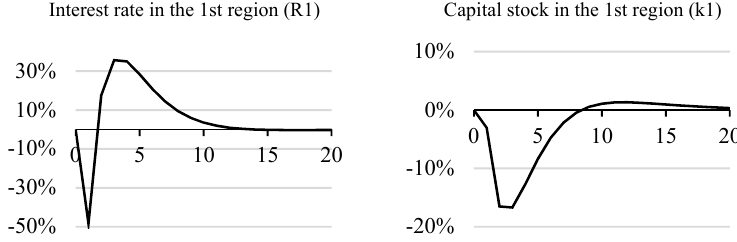
Figure 6. Net flows of factors of production from the first to the second region. Exports of goods from the first region to the second are declining against the back- ground of a decrease in consumer activity in the latter, which contributes to the decline in the first region. Conversely, the growth of consumer spending in the first region stimu- lates the import of goods from the second region and economic activity within it (Figure 7). Figure 7. Export from first to second region and export from second to first region. Output in the second region is growing primarily due to the growth of exports to the first region (Figure 8).